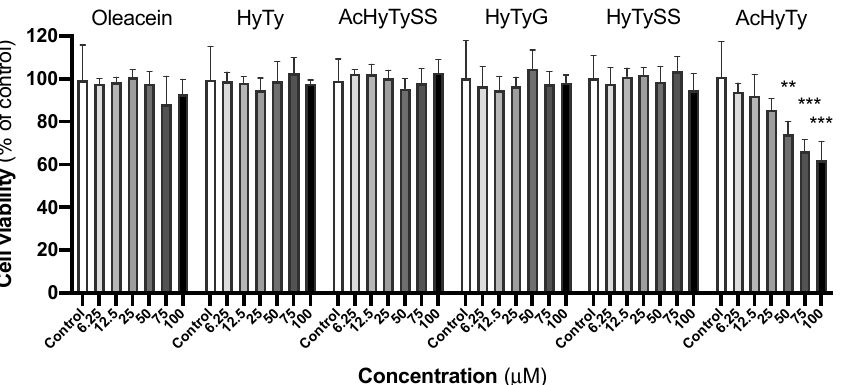
Figure 2. Effect of increasing concentrations of oleacein, HyTy, AcHyTySS, AcHyTy, HyTyG and HyTySS on cell viability of non-activated RAW 264.7 cells, after 24 h of exposure, assessed by MTT reduction. Results are expressed as the mean ± SEM of four independent assays, each performed in triplicate. ** p < 0.01; *** p < 0.001 compared to the respective control.